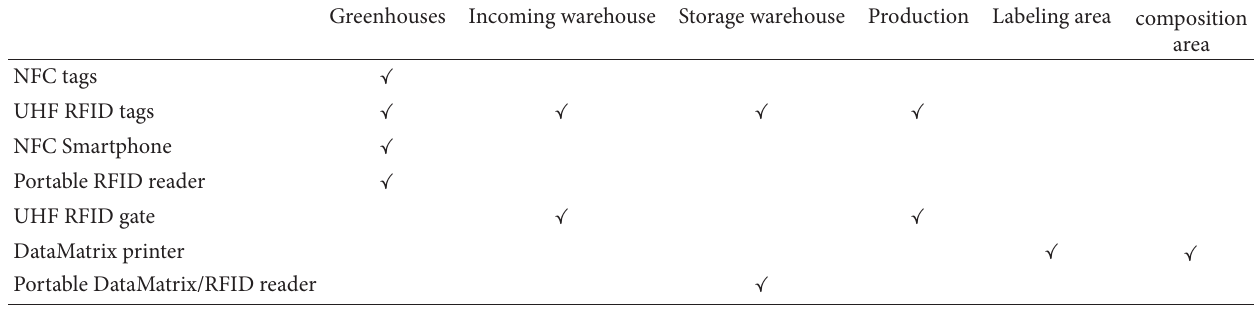
Table 1: Mapping between RF devices and working areas in the Jentu company.